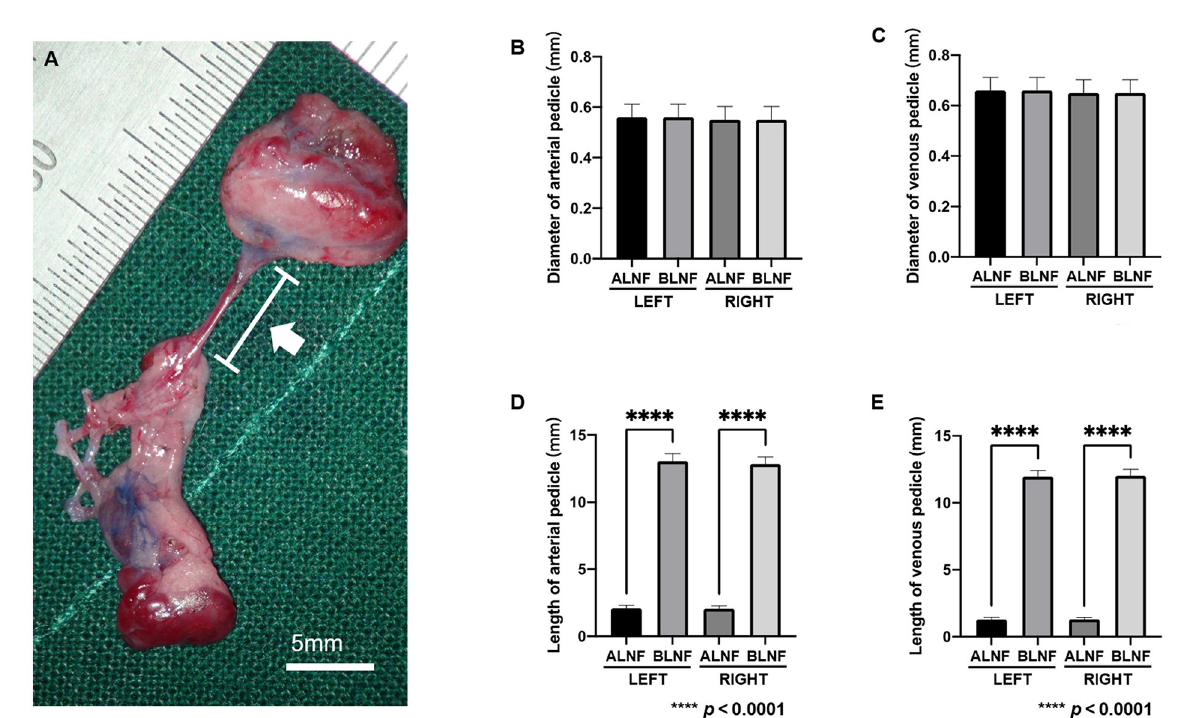
FIGURE5 (A) Photographic image for the vascular pedicle in the harvested LNFs (white arrow). The scale bar is 5mm. (B) The measurement data of the length and diameter of the vascular pedicle of the LNFs. Comparison of arterial pedicle diameter among groups. (C) Comparison of venous pedicle diameter among groups. (D) The difference in the length of the arterial pedicle between the ipsilateral ALNF and BLNF is compared; the length of the arterial pedicle of the same type of flap on different sides is compared. (E) The difference in the length of the venous pedicle between the ipsilateral ALNF and BLNF is compared; the length of the venous pedicle of the same type of LNF on different sides is compared. **** indicate the p-value between each group ( p <